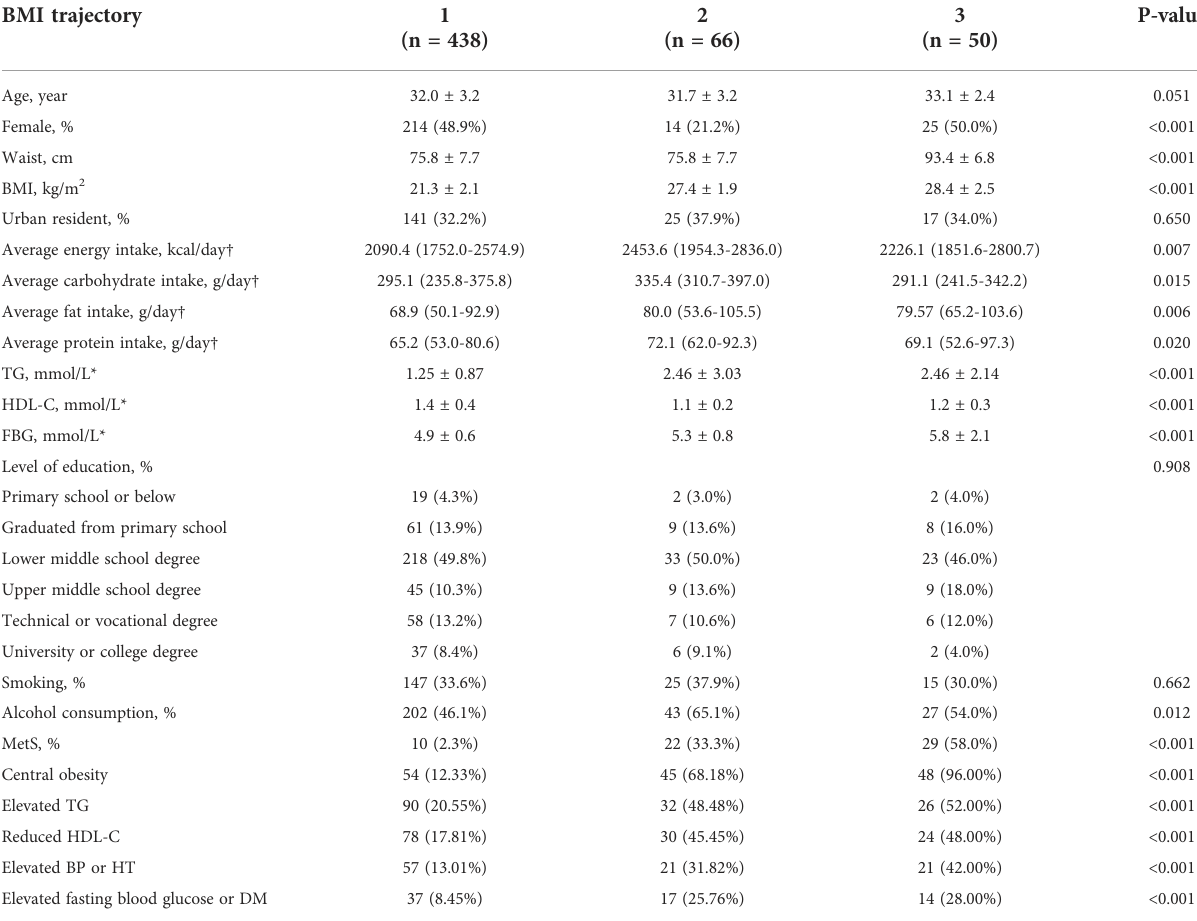
TABLE 3 Baseline characteristics by different classes at